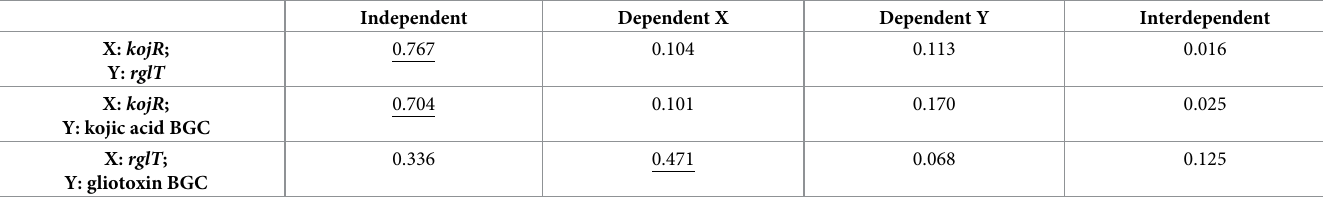
Table 1. Akaike Information Criterium (AIC) of model fitting for phylogenetic correlation tests.